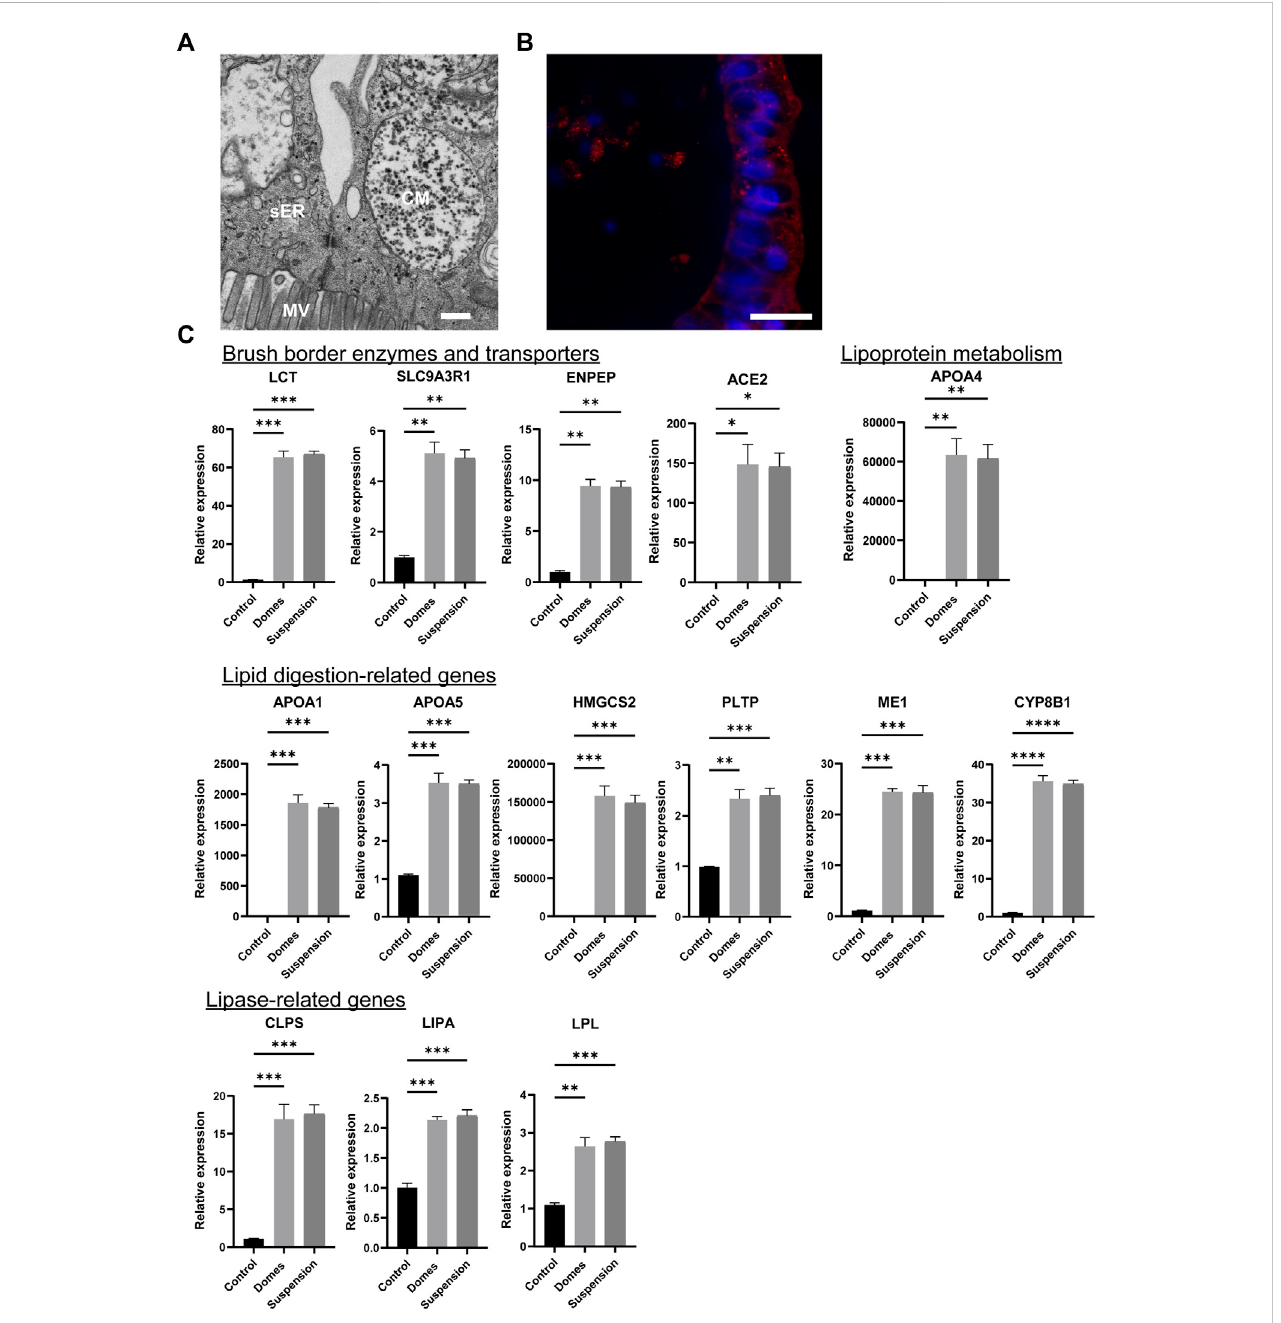
FIGURE 4 Suspensionintestinal organoids recapitulate invivo metabolic activity. (A) TEMdemonstrates thepresence of chylomicrons(CM) and vesicles ofsmooth endoplasmic reticulum (sER) in apical-out organoids. MV: microvilli. Scale bar: 500 nm. (B) Nile red staining indicating the lipid droplets in the cytosol of apical-out intestinal organoids. Scale bar: 20 μ m. (C) qRT-PCR analysis demonstrates the expression levels of the brush borders enzymes and transporters ( LCT, SLC9A3R1, ENPEP, ACE2 ); the lipoprotein metabolism-related gene ( APOA4 ); the lipid digestion-related genes ( APOA1, APOA5, HMGCS2, PLTP, ME1, CYP8B1 ) and the lipase-related genes ( CLPS, LIPA, LPL ) in both apical-in (domes) and apical-out (suspension) intestinal organoids. Untreated H9 embryonic stem cells were used as controls. Error bars indicate mean ± S.E.M ( n =